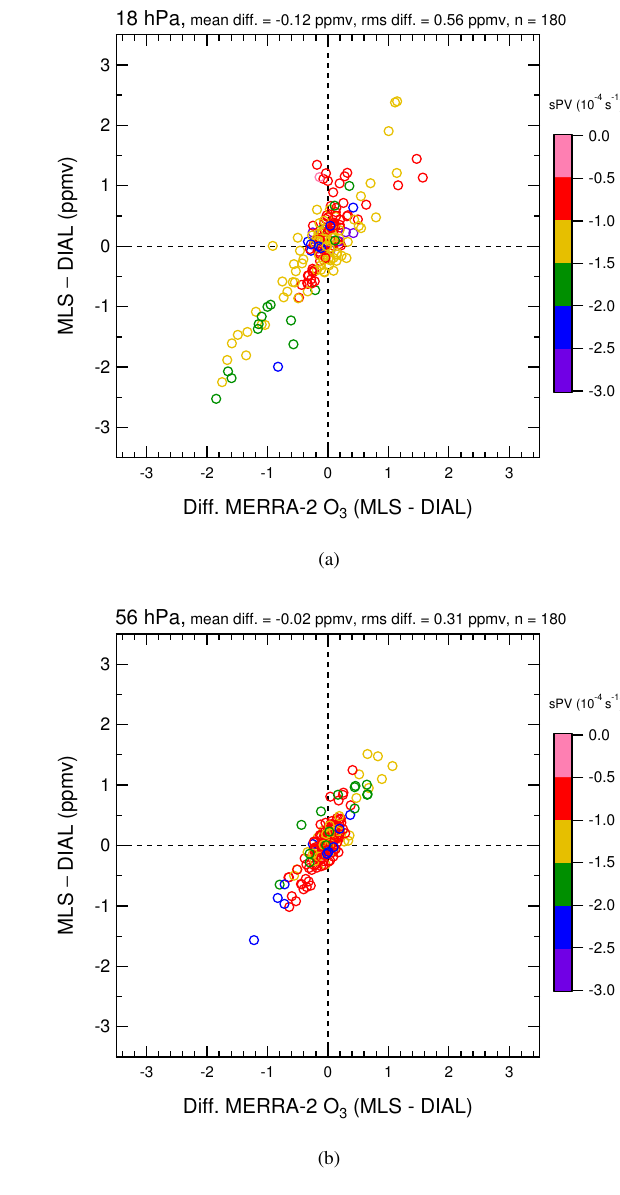
Figure 8. O 3 difference versus MERRA-2 O 3 difference for DIAL and MLS at 18hPa (a) and 56hPa (b) . Data are color coded based on the sPV for the MLS